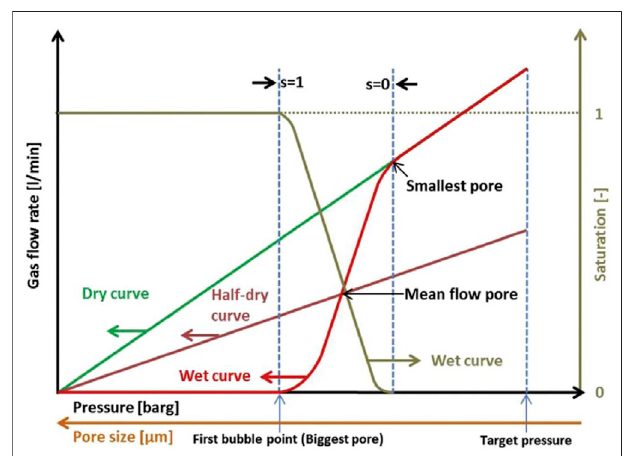
FIGURE 2 | An example of a wet curve, dry curve, and half-dry curve obtained by capillary fl ow porometry. Reproduced with permission from Bromberger et